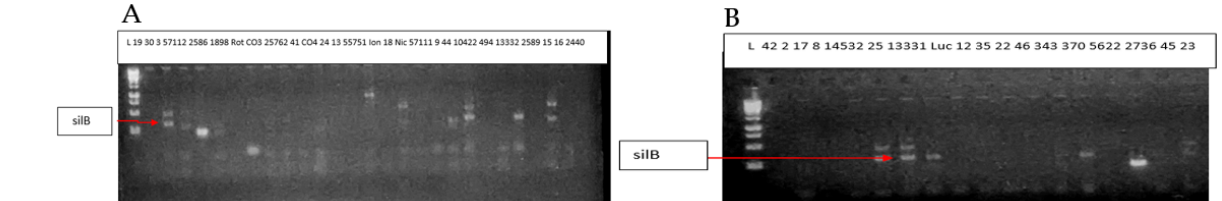
Figure 4. Electropherogram of amplicons obtained by PCR for SilE, SilS, and SilP genes. ( A ) Wells 3–27—amplicons of the analyzed strains; well no. 28, L-GeneRuler molecular weight marker 3000 bp (Mid Range DNA); Positive strains: E. coli —258 for the silE gene. ( B ) Wells 1–22—amplicons of the analyzed strains; well no. 23, L-molecular weight marker GeneRuler 3000 bp (Mid Range DNA); Positive strains for the SilS gene: S. xylosus (17).